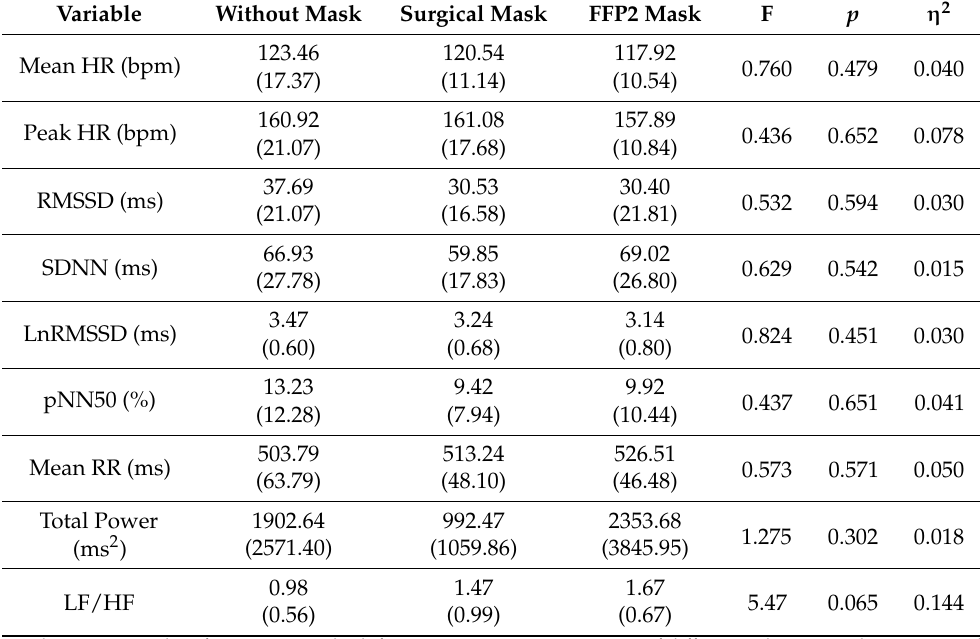
Table 2. Heart rate and heart rate variability results after each training